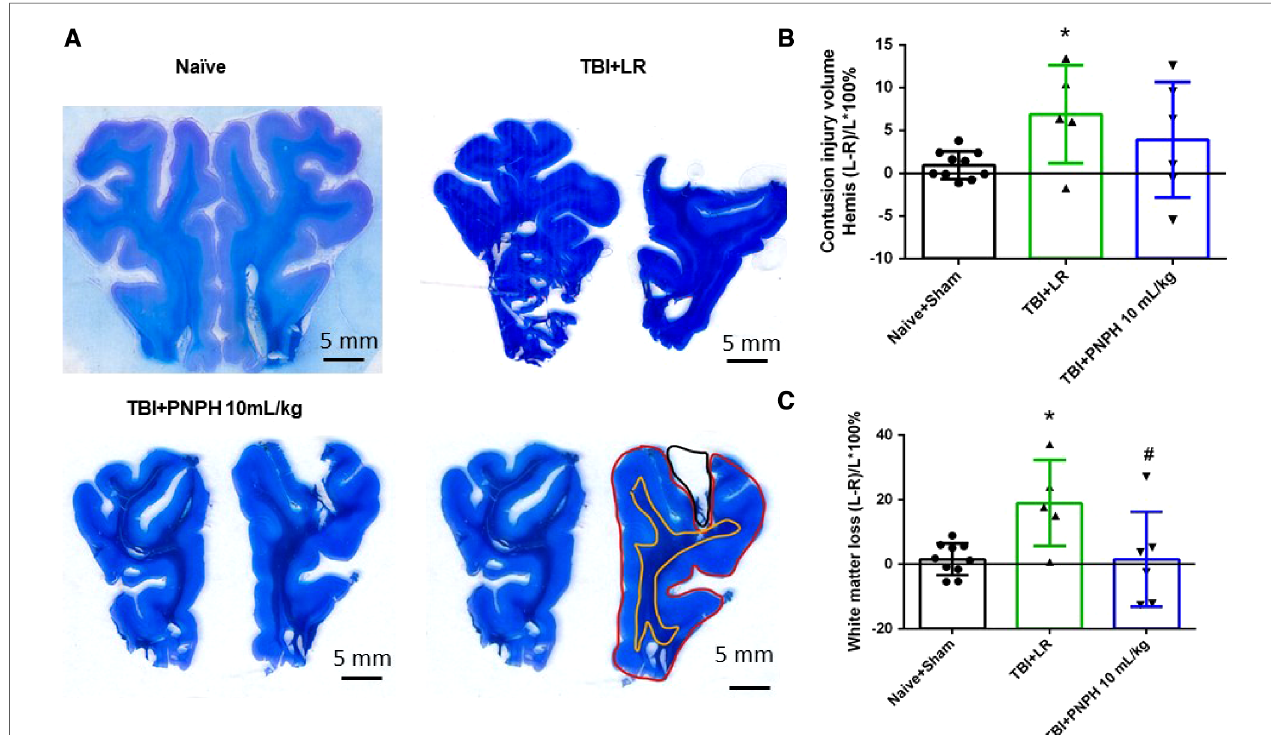
FIGURE 8 Effect of PNPH on frontal lobe contusion injury volume and volumetric white matter loss after TBI without hemorrhagic shock. ( A ) Representative coronal sections (both hemispheres, top is superior) of frontal lobe of normal pig brain and brains 4 days after TBI and infusion of 10 ml/kg lactated Ringer ’ s (LR) solution and 10 ml/kg PNPH. Gray matter is visualized with cresyl violet staining and subcortical white matter myelin is visualized with Luxol fast blue staining. Area delineated by red trace is the entire histologically normal hemisphere, area delineated by the yellow trace is the white matter, and area delineated by the black trace is the contusion site. ( B ) Contusion injury volume (intact tissue difference of left minus right hemisphere as a percentage of left hemisphere volume contralateral to the injury site) of pigs subjected to TBI followed at 120 min with LR ( n =6) or PNPH ( n =6). The normal variation in the difference of left minus right hemisphere volume as a percentage of left hemisphere volume is shown for the combined Naïve ( n =5) and Sham ( n =5) group. ( C ) Volume of white matter loss in the same brains was calculated as the difference between left minus right subcortical white matter volume normalized by the left subcortical white matter volume (contralateral volume). White matter loss was decreased with PNPH treatment. Mean±SD and individual data for each pig are shown. * P <0.05 vs. Naïve+Sham group, # P <0.05 vs. LR group determined by one-way ANOVA and the Holm-Sidak procedure for multiple